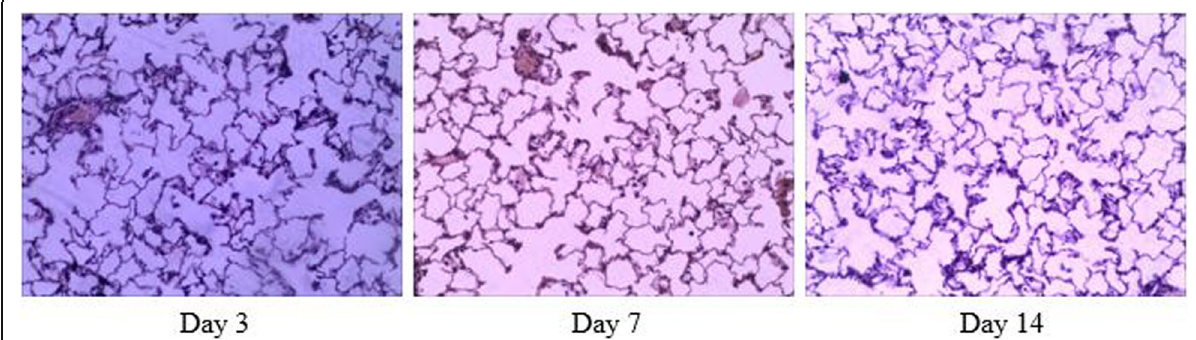
Fig. 3 Lung histopathological observation of negative control